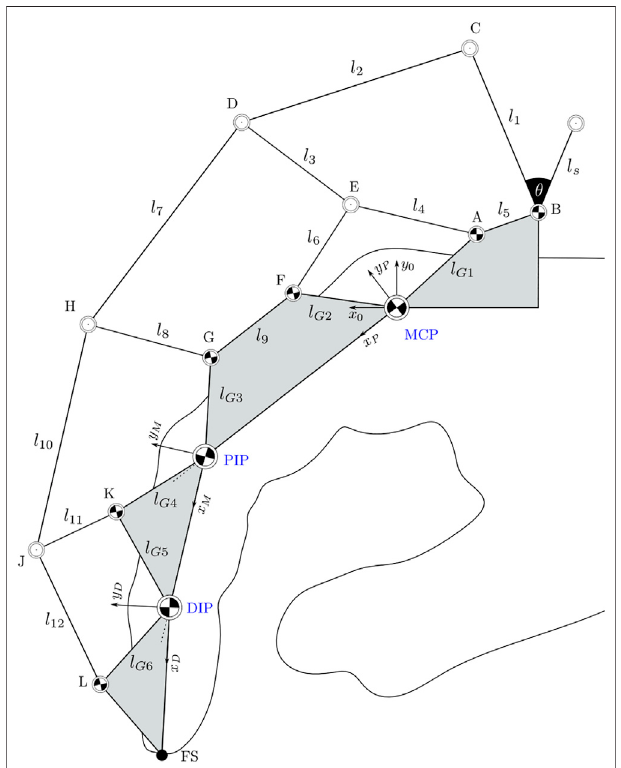
FIGURE2| Linkagestructureoftheexoskeletonsystemasanextension to Jo and Bae (2017). The fi nger joints are marked in blue. Areas marked in grey are considered as rigid bodies within the structure.